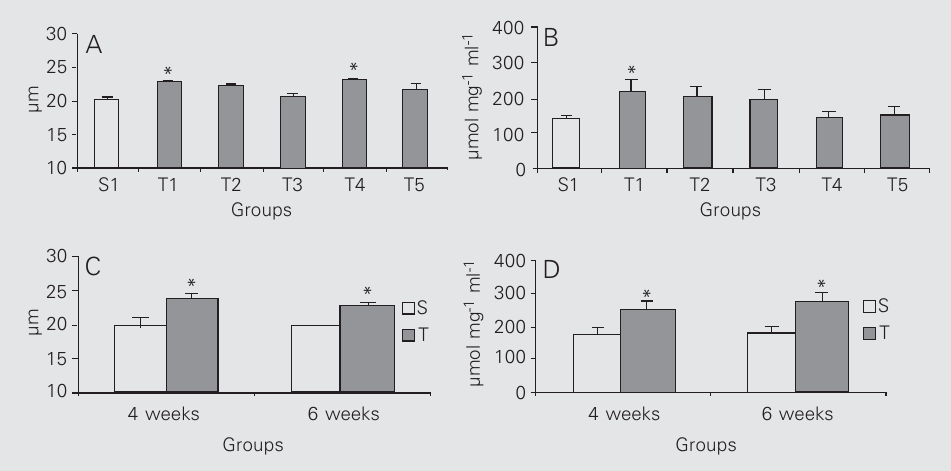
Figure 3. Left cardiac myocyte dimensions and skeletal muscle maximal citrate synthase activ- ity following physical training in Protocols 1 (A and B) and 2 (C and D). Data are reported as means ± SEM. *P < 0.05 com- pared to the sedentary groups S1 (A and B; one-way ANOVA test) and S (C and D; two-way ANOVA